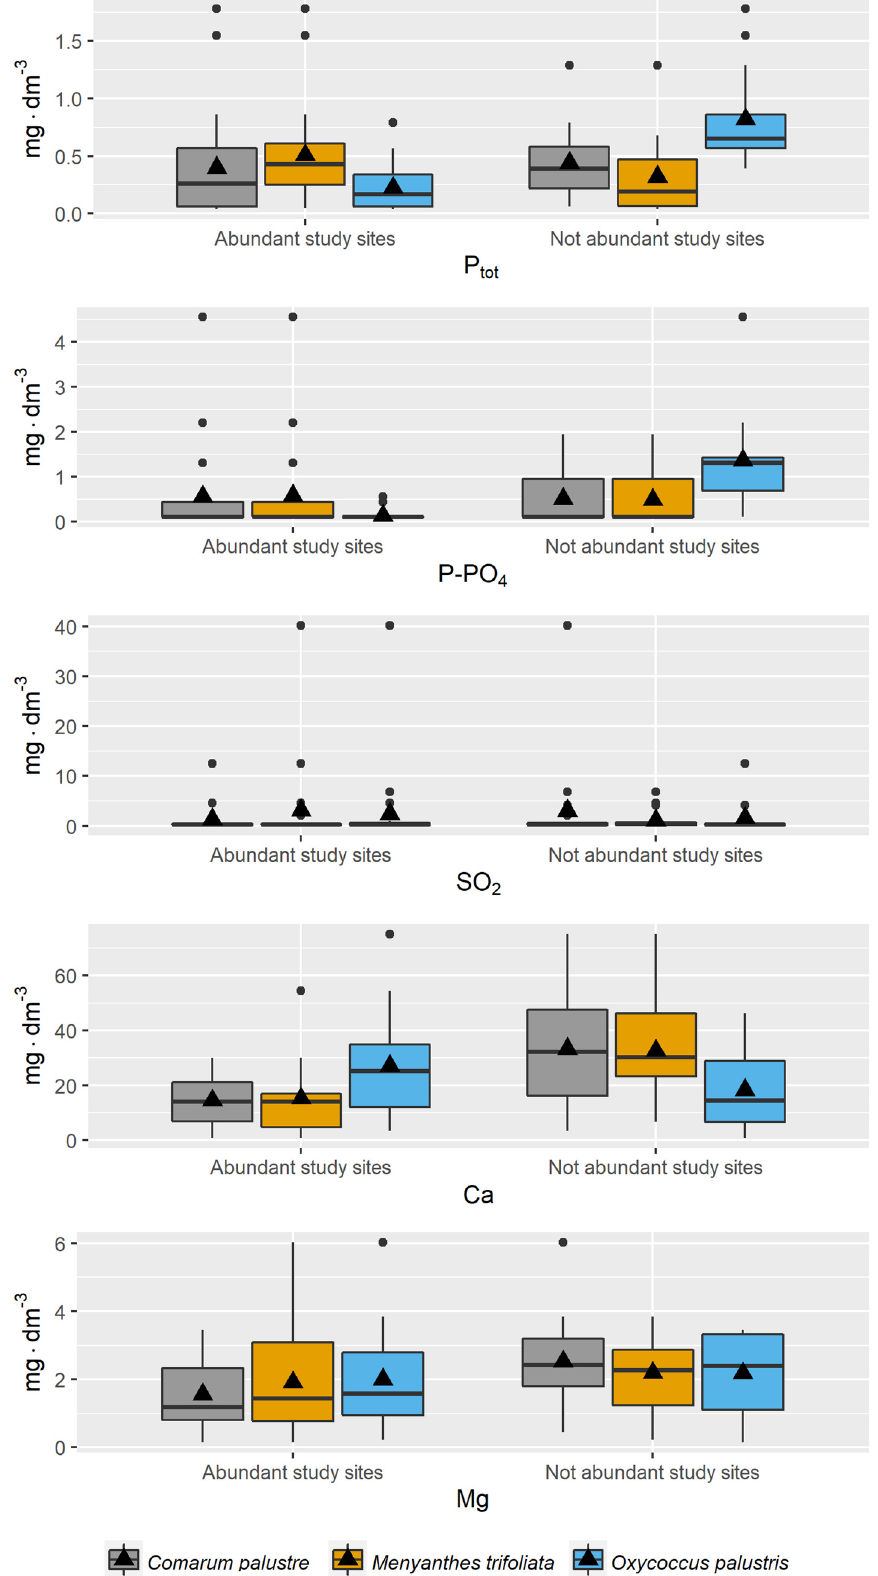
Figure 4. Distribution of values of phosphorus fractions, SO 2 , Ca, and Mg in piezometric groundwater at the study sites for the study species in 2011–2013 (criterion of abundance in habitats).